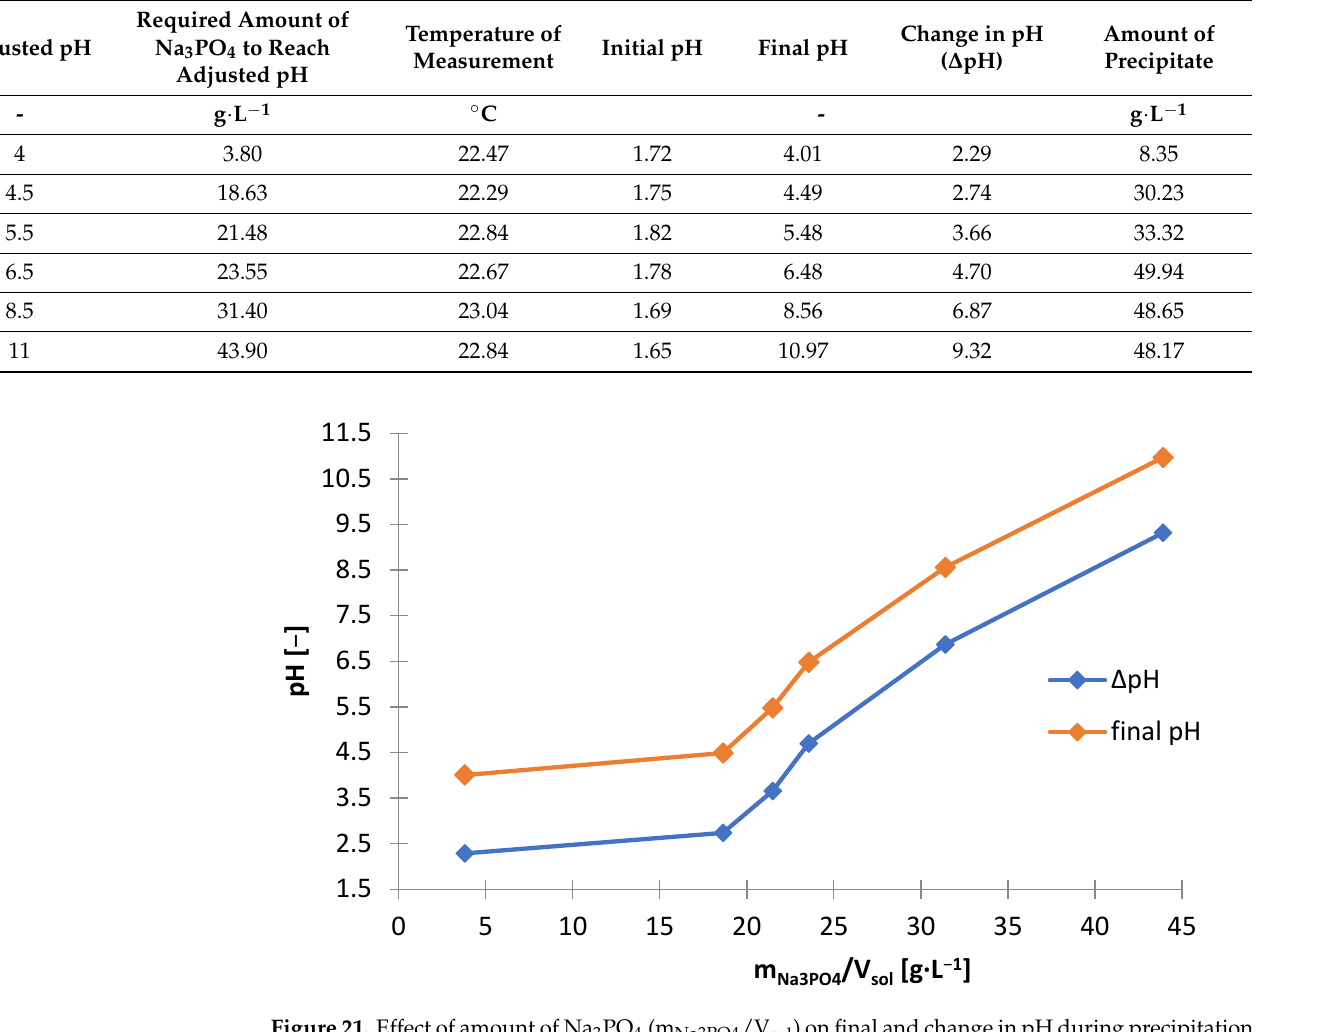
Figure 21. Effect of amount of Na 3 PO 4 (m Na3PO4 /V sol ) on final and change in pH during precipitation from solution after selective leaching.